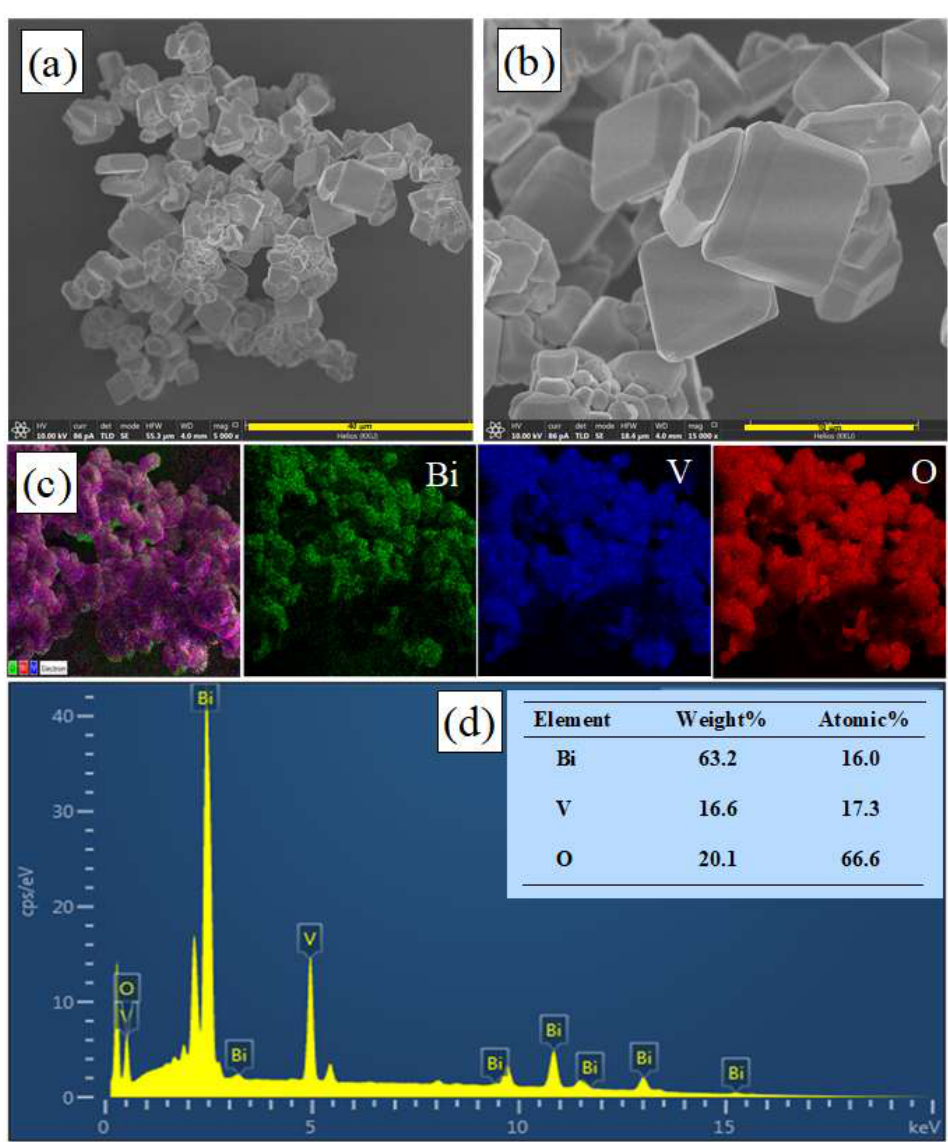
Figure 2. SEM micrographs ( a , b ), SEM micrograph of the mapping area and EDX elementary mapping of Bi, V, and O ( c ), and EDX spectrum ( d ) of BiVO 4 . In addition, TEM and SAED methods were carried out to examine the structural in Figure 3a,b display a size of about 5.28 µ m. In addition, the crystalline structure was obtained from the high-resolution TEM (HR-TEM) micrograph (Figure 3c). On examination of the lattice fringes, the interplanar lattice spacing (d) of 0.32 nm is due to the reflection from the (121) crystal plane of the monoclinic BiVO 4 . The selected area electron diffraction (SAED) pattern in Figure 3d revealed the monocrystalline nature of the catalyst [3,33]. The SAED pattern was mainly caused by the reflection from the (202), (220), and (251) crystal planes. This is in good agreement with those found in the XRD diffractogram results (Figure 1a).